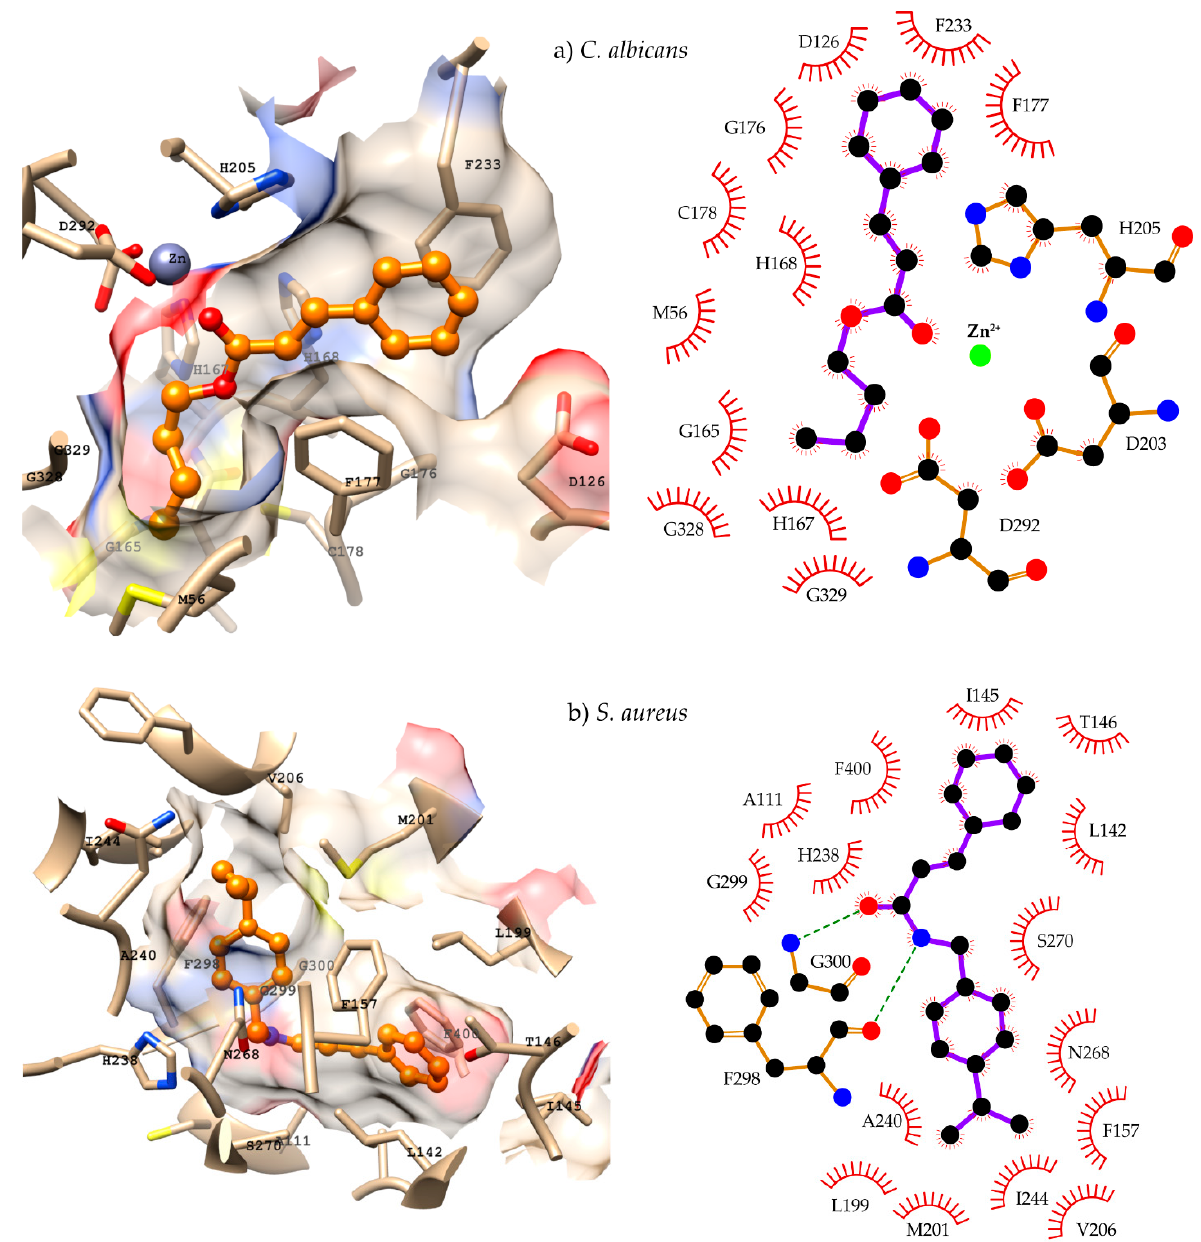
Figure 4. Predicted binding modes of compounds 6 and 18 to caHOS2 ( a ) and saFABH ( b ) with diagrams of the predicted ligand–receptor interactions. The ligands are represented as orange balls and sticks. Labeled residues correspond to those interacting with the receptors in at least 50% of the analyzed MD snapshots. Atoms are shown for residues either forming hydrogen bonds with the ligand or coordinating the Zn 2+ ion.